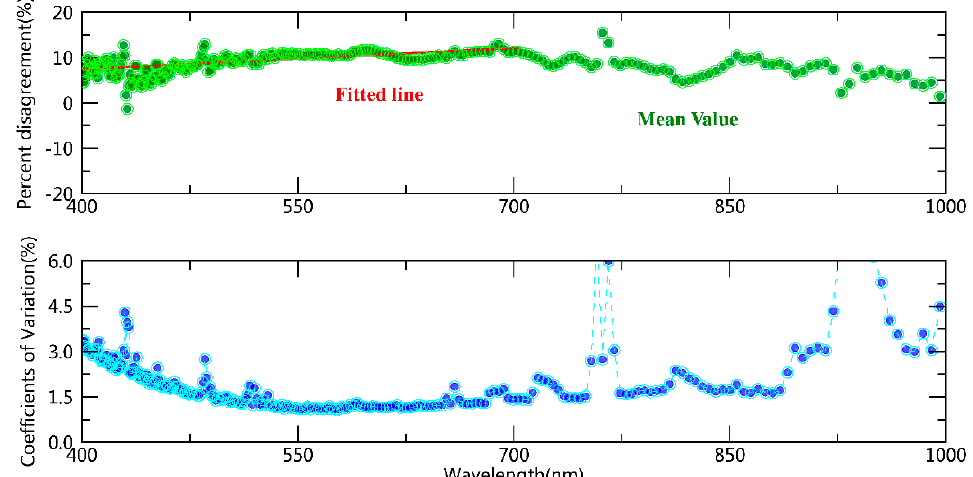
Figure 14. Comparison of lunar irradiances with the USGS model in different wavelengths. The vertical coordinate is dimensionless, and it shows the specific value between the measured irradiance and lunar model. Over the 3-month course of the mission, the imaging spectrometer has made observations at phase angles from 6° to 85°, and the plot symbols represent 465.39, 486.67, 544.17, 553.02, 664.81, 692.85, 702.81, 746.01, 773.83, 864.66, 874.69, and 884.89 nm for a lunar spectrum in the spectrometer bands, which are similar to the ROLO bands.